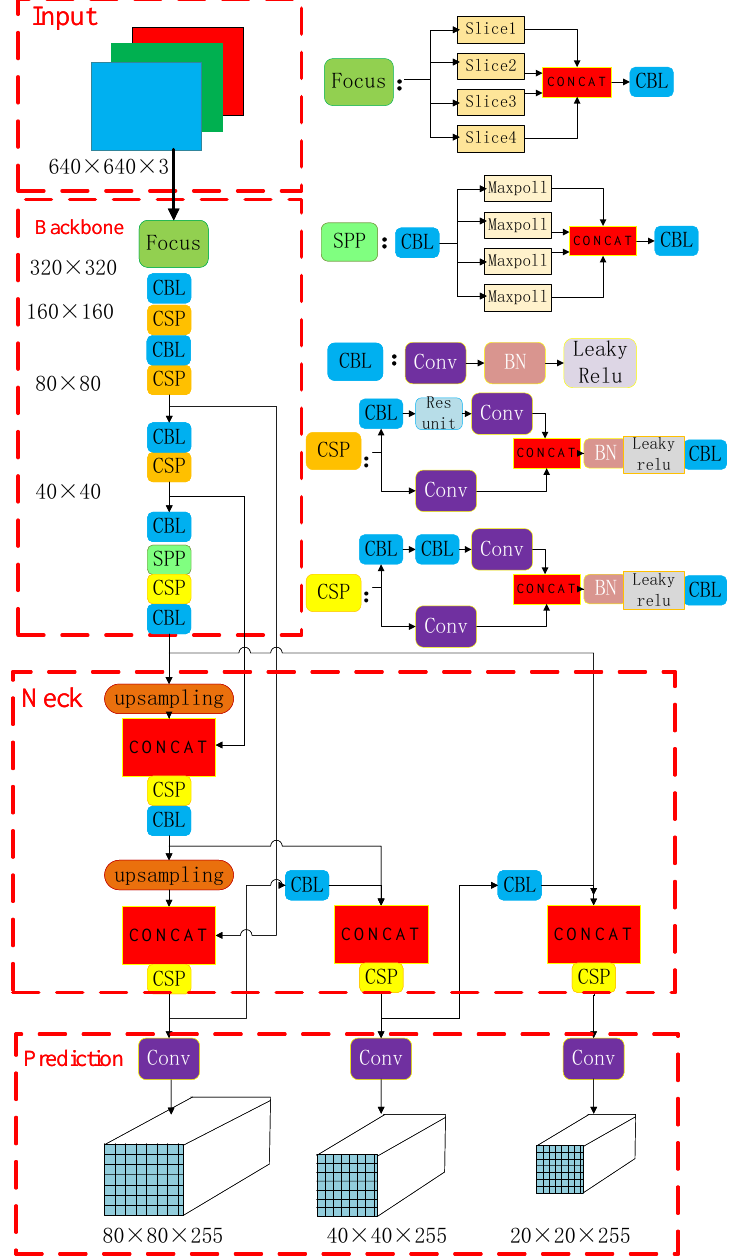
Figure 2. The network structure diagram of Yolov5.